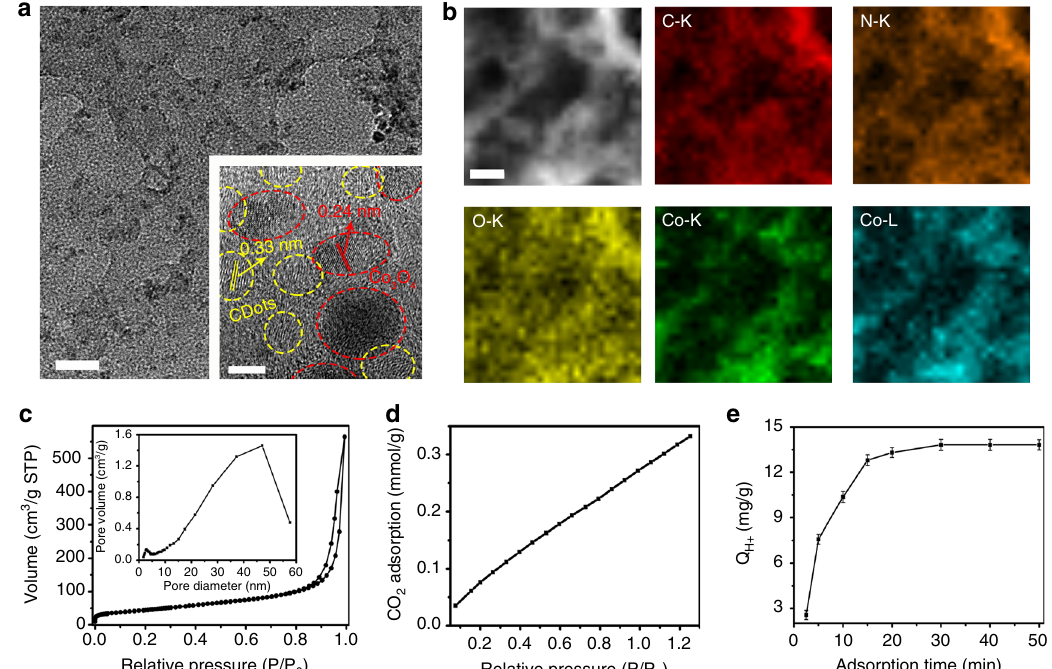
Fig. 1 Characterization of the Co 3 O 4 -CDots-C 3 N 4 . a TEM image of a grain of the Co 3 O 4 -CDots-C 3 N 4 and a HRTEM image of Co 3 O 4 -CDots-C 3 N 4 (inset), scale bar 20 nm and 5 nm (inset). b STEM micrograph and the corresponding elemental mapping of C-K, N-K, O-K, Co-K, and Co-L for the Co 3 O 4 -CDots- C 3 N 4 , scale bar 50 nm. c N 2 adsorption – desorption isotherm and the corresponding pore-size distribution of Co 3 O 4 -CDots-C 3 N 4 (inset). d CO 2 adsorption isotherm of Co 3 O 4 -CDots-C 3 N 4 . e The time-course adsorption of H + by the Co 3 O 4 -CDots-C 3 N 4 . The adsorption is 13.8 mg/g. Experiments were performed in triplicates and results are shown as mean ± standard